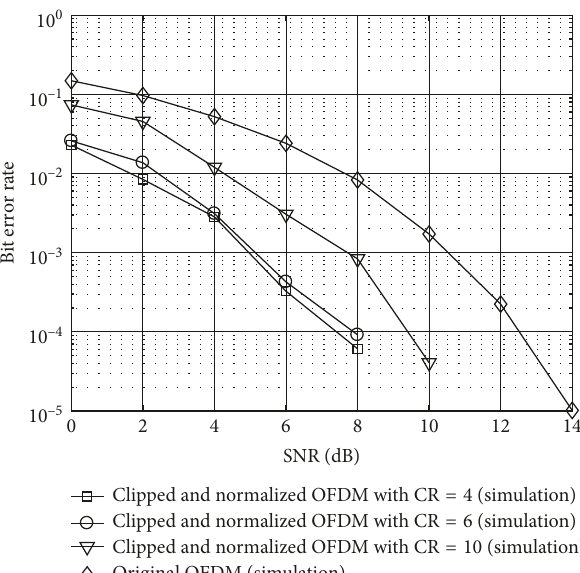
Figure 7: BER performance comparison for different clipped and normalized OFDM over the fiber channel by simulation.